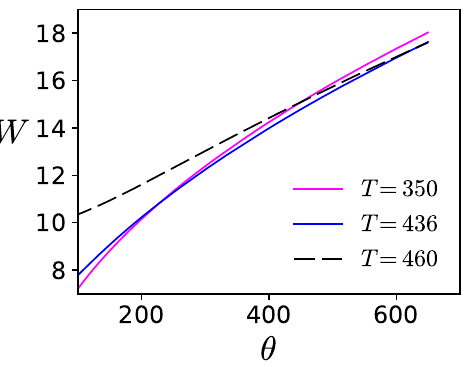
Figure 8. Roughness as a function of the thickness in deposits grown with parameter sets C ( T ( C ) = 350 K) (magenta curve), C1 ( T ( C1 ) = 436 K) (blue curve), and at a higher temperature ( T ( C (cid:48) ) = 460 K) (dashed black curve). All lengths are in units of the lattice